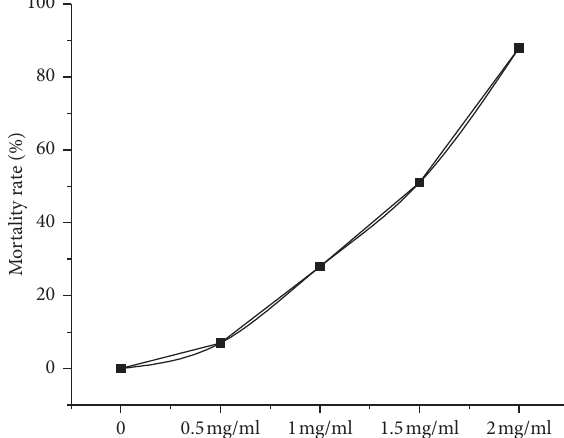
Figure 1: Essential oil of the flesh finger citron causes mortality of C. elegans . At least three independent biological replications were performed, and statistical significance of the difference between the curves was demonstrated by origin analysis.